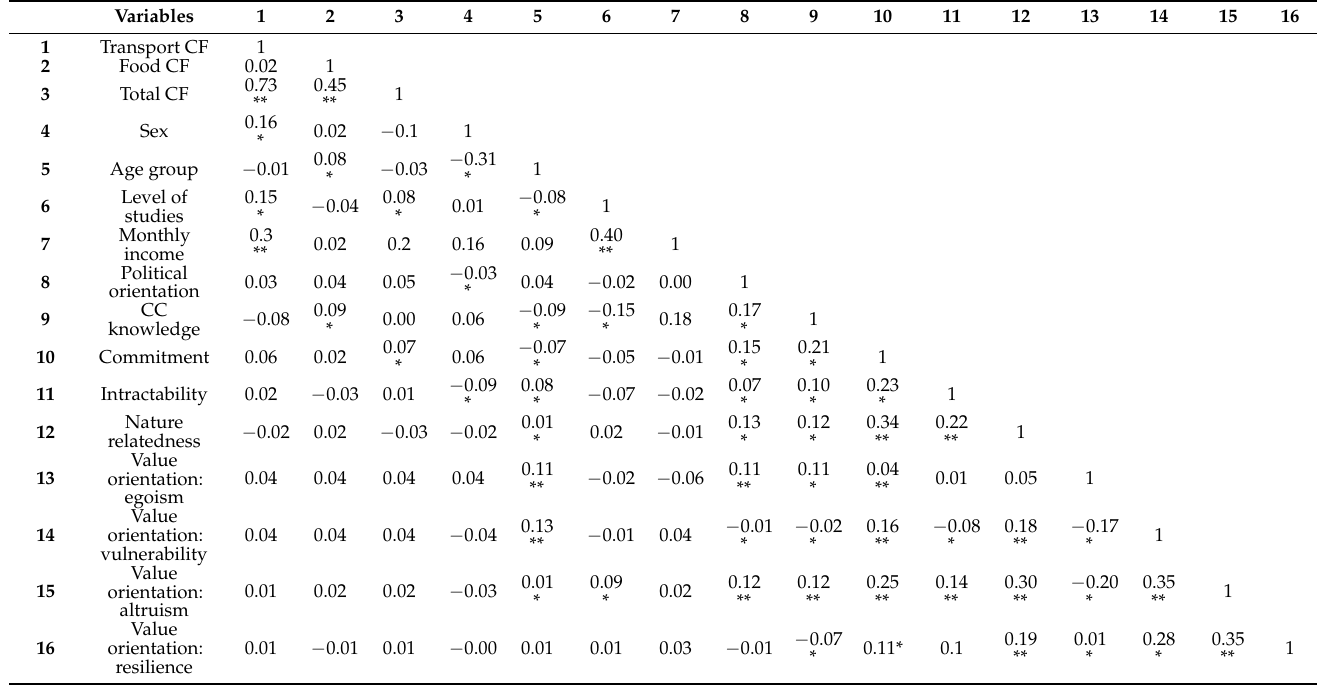
Table A2. Spearman correlation coefficients. P -values lower than 0.001 are marked as ** and lower than 0.01 as *.